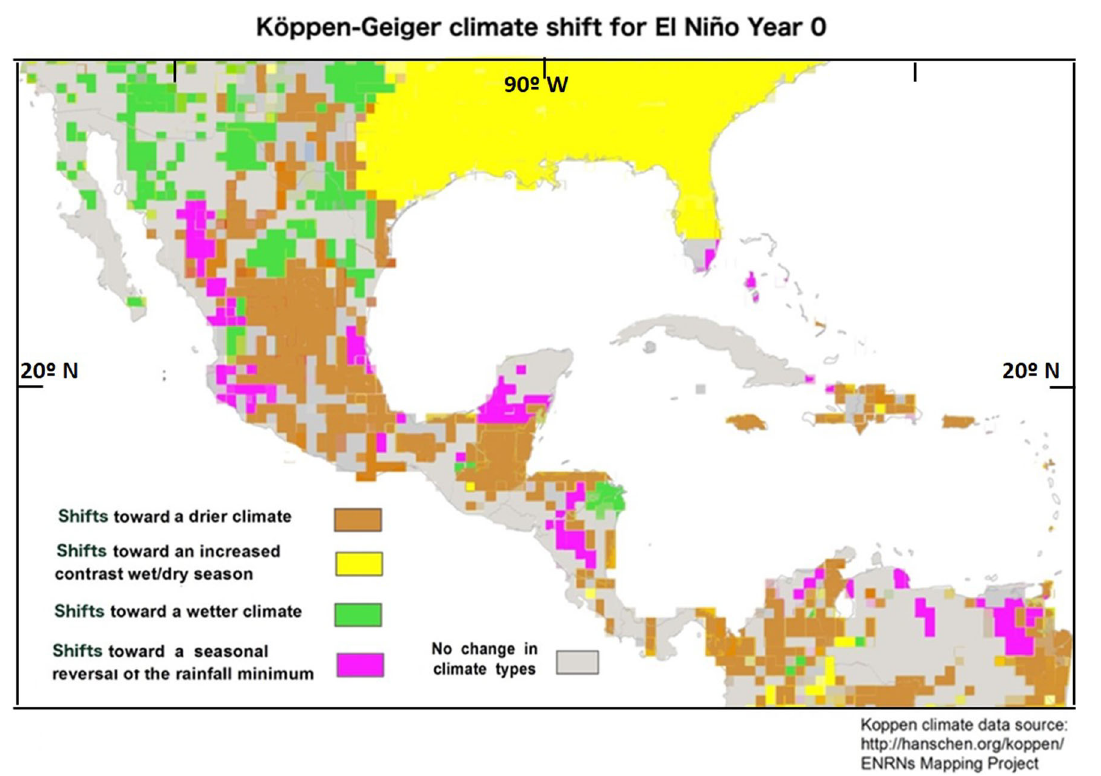
Fig. 7 Major climate shift types for rainfall regime in El Nin˜o Year 0 based on five strong El Nin˜os in the Central American and circum- Caribbean